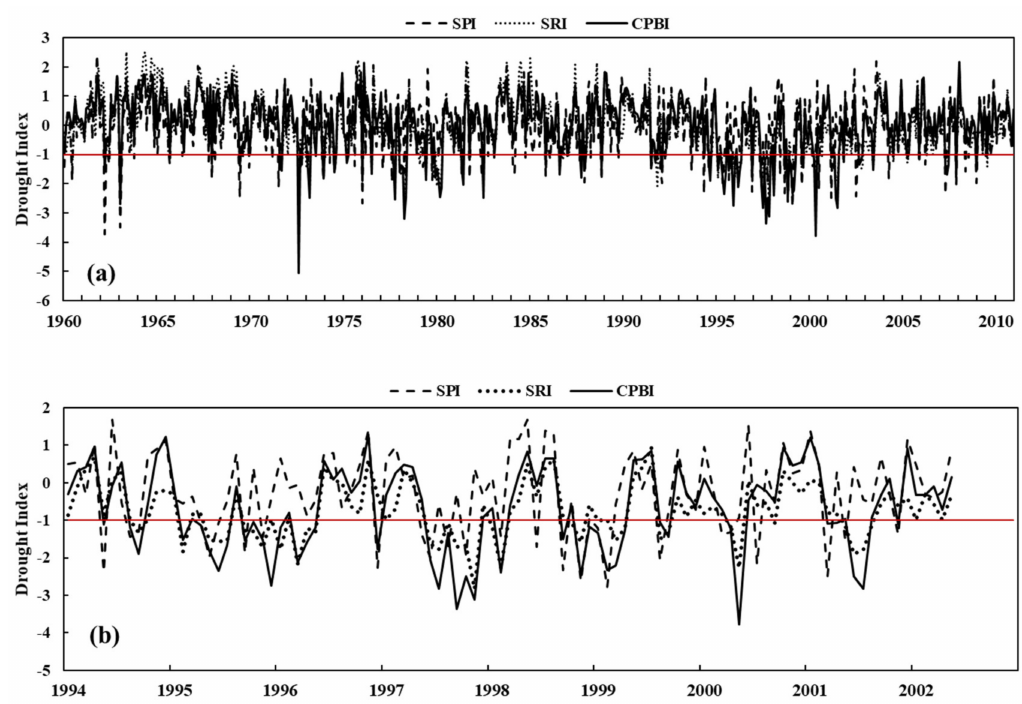
Figure 2. The drought index of SPI, SRI and CPBI in Huaxian station of Weihe River. ( a ) 1960 − 2010 in monthly; ( b ) 1994 − 2010 in